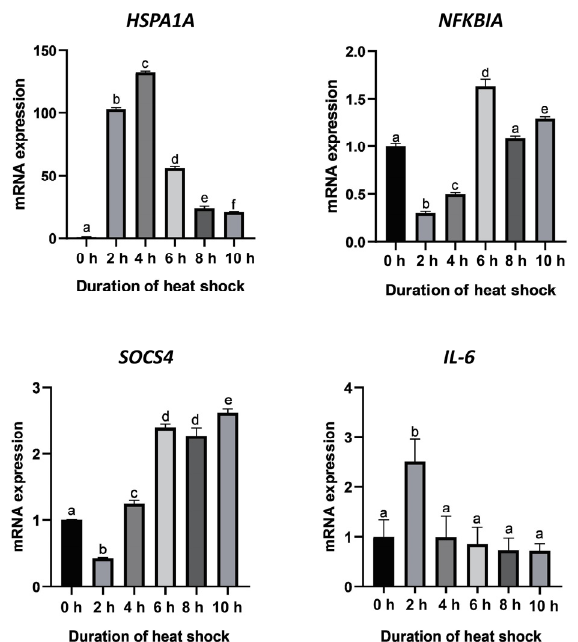
Figure 4. Expression levels of the four candidate genes at different heat shock durations. Means without a common superscript are significantly different ( p < 0.05) from others.